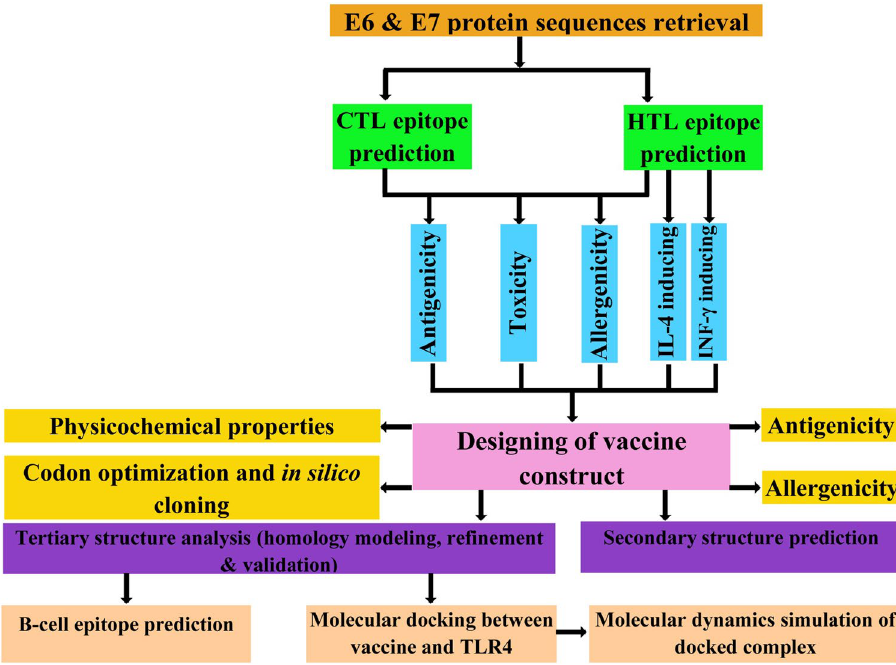
Figure 1. A schematic illustration of the immunoinformatics approaches used to design a multi-epitope vaccine.